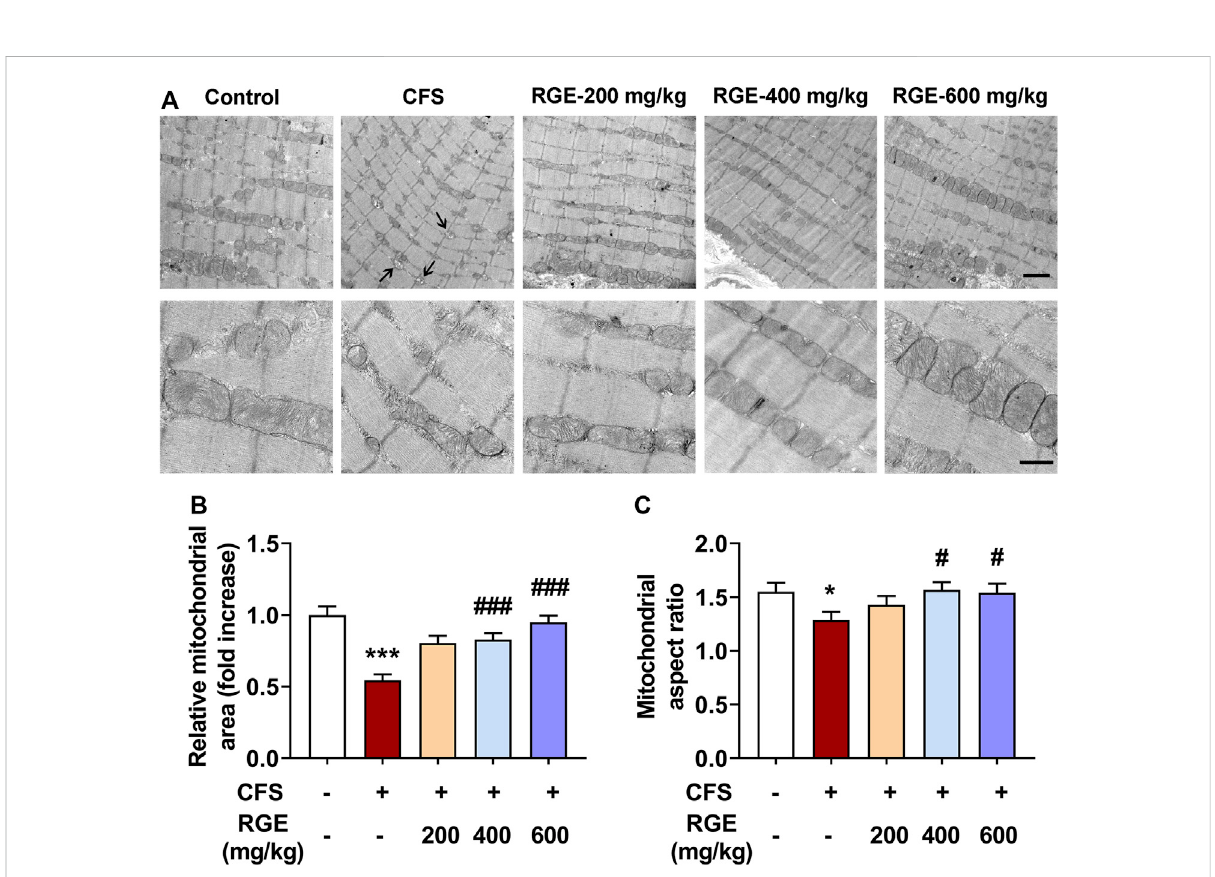
FIGURE 3 The effect of RGE on mitochondrial morphology in TA muscle of multiple stress factors-induced chronic fatigue mice. (A) . Morphology of mitochondria was observed by Transmission Electron Microscopy with magni fi cation of 50,000x or 15,000x. Note the vacuolation degeneration of mitochondria with vague and dissolved cristae (arrows). Scale bar = 2 μ m (up panel), or 0.5 μ m (down panel). B-C. Quantitative analysis of mitochondrial area (B) and aspect ratio (C) in TA muscles of the indicated groups. Mice from control or chronic fatigue syndrome model group were treated with water or different dose of RGE (200, 400or 600 mg/kg). n = 13 representative EM fi elds per group. Compared with control group, * p < 0.05, *** p < 0.001; compared with CFS group, # p < 0.05, ### p <